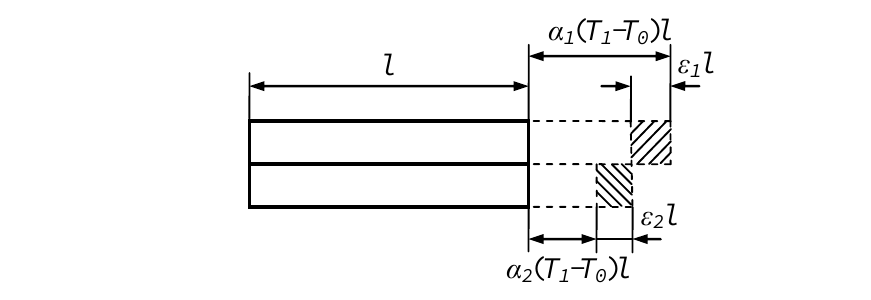
Figure 7. Thermal stress induced between two bonded materials when temperature was changed from T to T 0 1